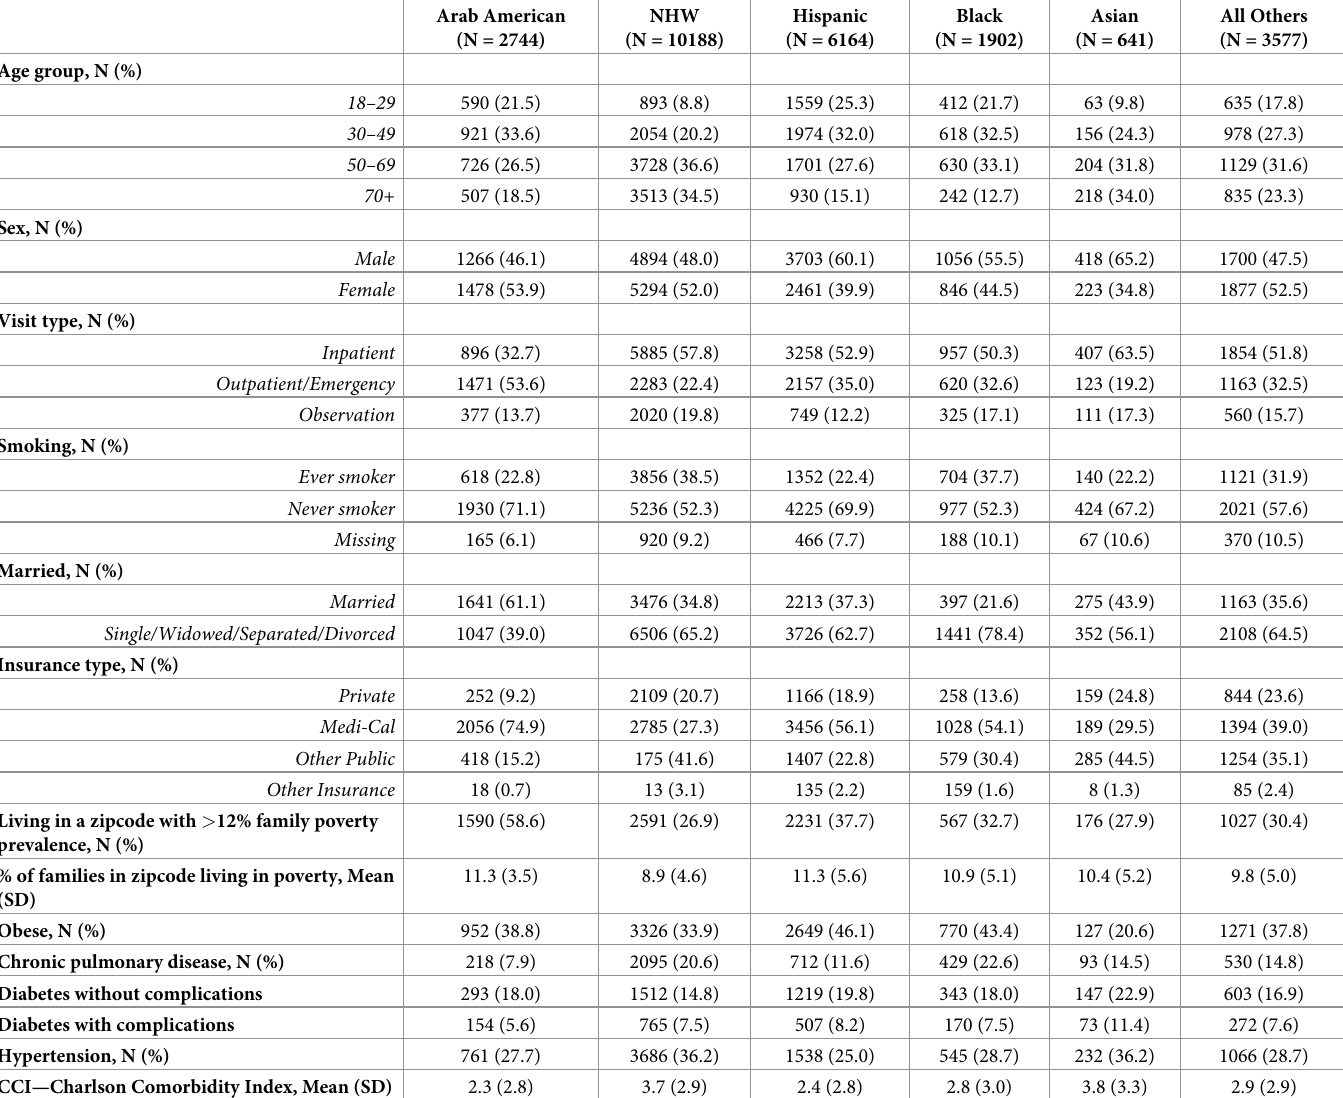
Table 1. Comparison of sociodemographics and outcomes across racial and ethnic groups among patients who were tested for COVID-19 in the Sharp Grossmont electronic medical record between March 1, 2020 and January 31,